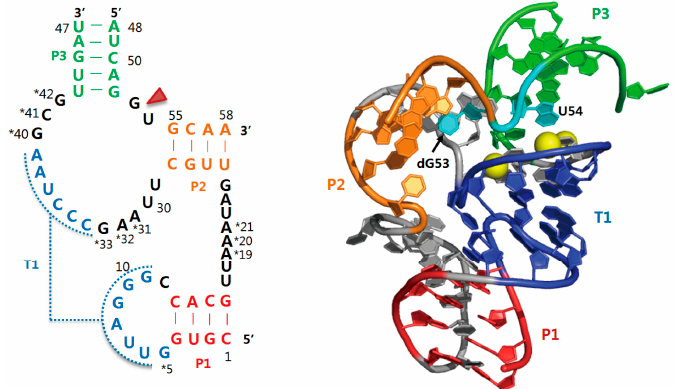
Figure 3. Secondary and tertiary structures of the env25 pistol ribozyme [34]. On the secondary structure ( left ); highly conserved nucleotides are marked by asterisks, and red arrowhead indicates the G53-U54 cleavage site. Stems (P1-P3) and pseudoknots (T1) are colour-coded in the tertiary structure ( right ). In particular, two nucleotides at the cleavage site and bound magnesium ions are coloured in cyan and yellow, respectively. PDB accession code is 5K7C.